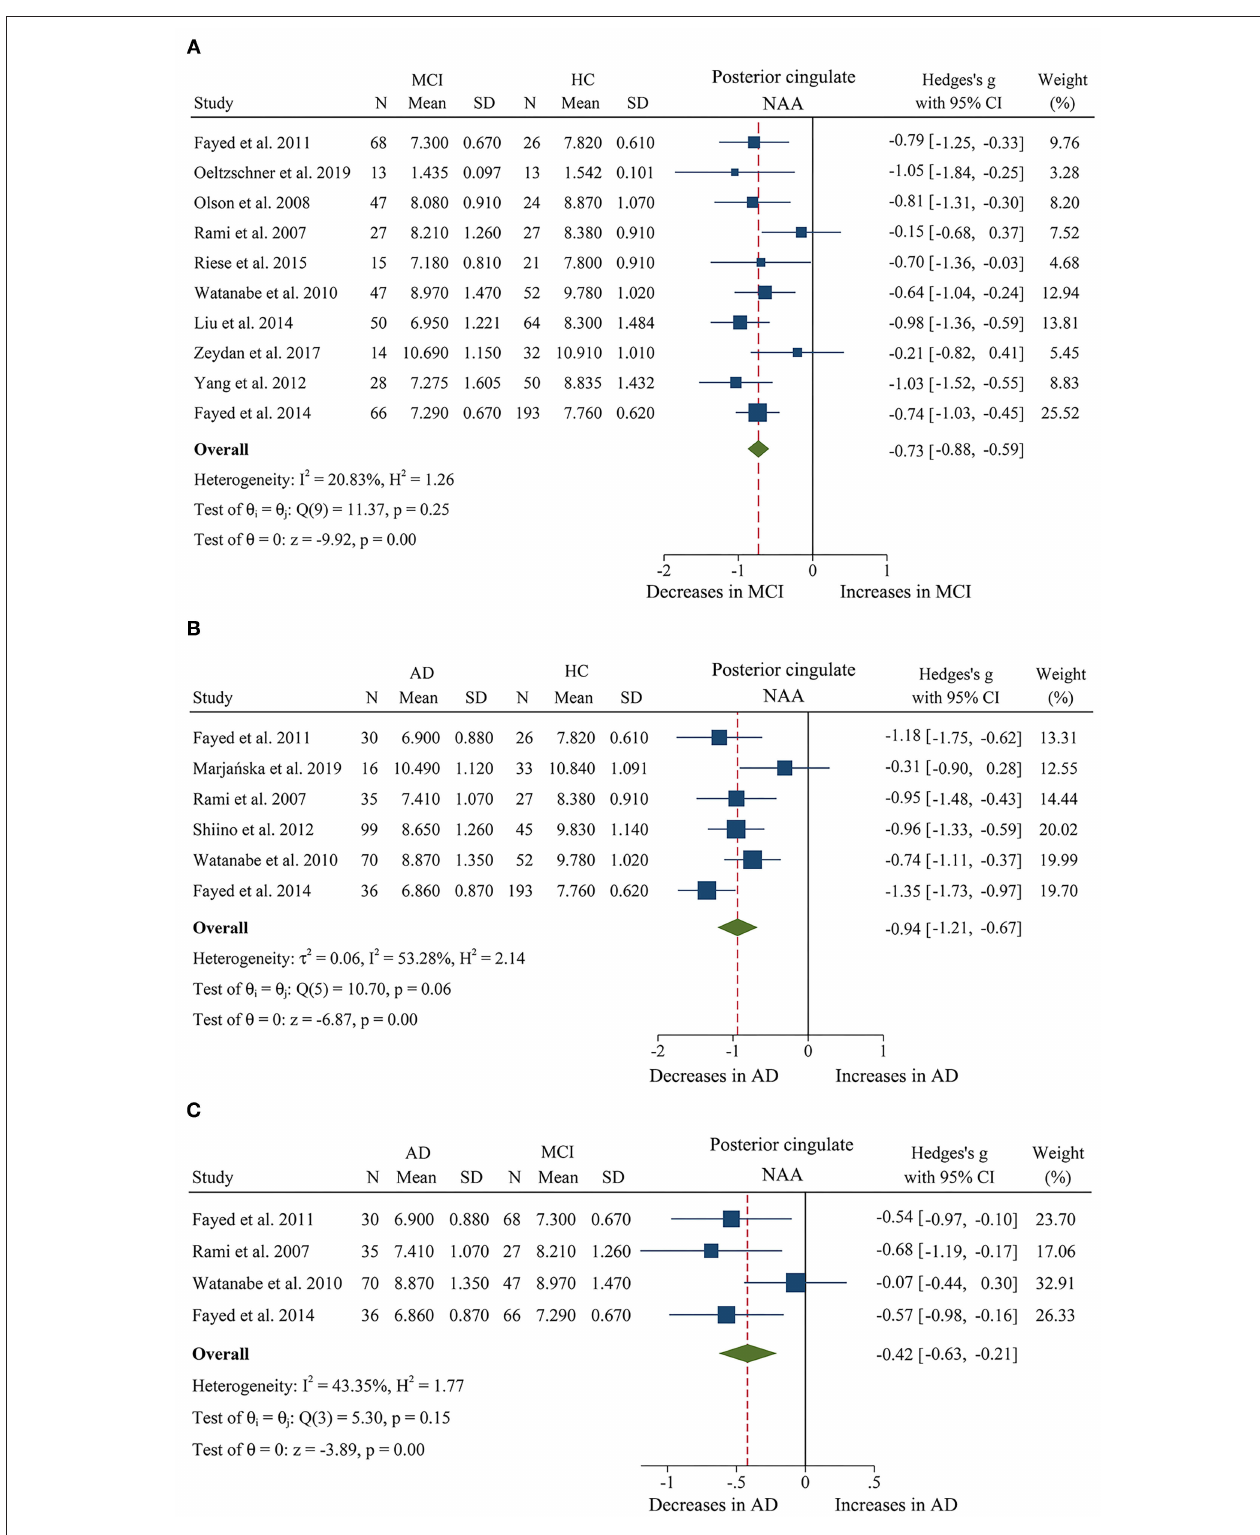
FIGURE 7 | Forest plots show the change of NAA in the posterior cingulate during the development from healthy people to AD. (A) Data include 877 individuals from 10 studies for meta-analysis of NAA levels between MCI and HC. (B) Data include 662 individuals from 6 studies for meta-analysis NAA levels between AD and HC. (C) Data include 379 individuals from 4 studies for meta-analysis NAA levels between AD and MCI.